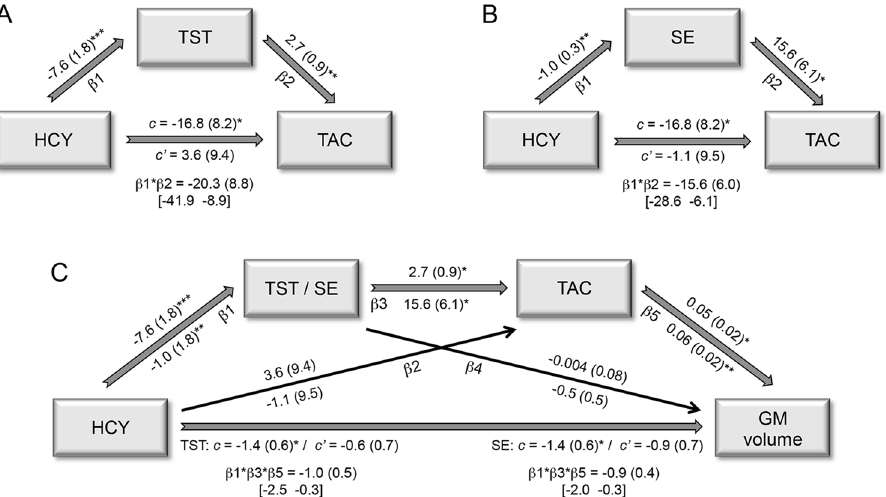
Figure 2. Single and multiple mediation effects. Standardized regression coefficients (standard error) for the relationship between HCY and TAC as mediated by total sleep time ( A ) or sleep efficiency ( B ) in MCI. ( C ) Standardized regression coefficients (standard error) for the relationship between HCY and GM loss as serially mediated by total sleep time/sleep efficiency and TAC in MCI. The standardized regression coefficient (standard error) between HCY and TAC or between HCY and cerebral GM before (c) and after controlling for either sleep or sleep and TAC (c’) are also indicated. Standardized regression coefficients (standard error) for the two-path ( β 1 * β 2) and three-path ( β 1 * β 3 * β 5) indirect effects together with the 95% bias-corrected bootstrap confidence intervals from 10,000 bootstrap samples are indicated in the bottom part of each model. * P < 0.05; ** P < 0.005; *** P <